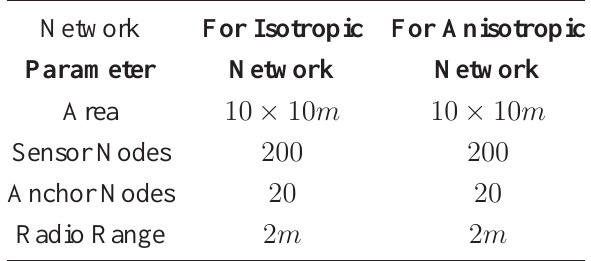
Table 2. Network Parameters for